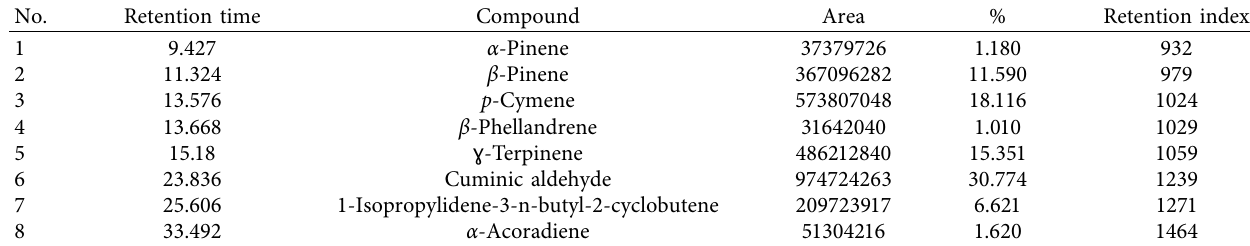
Table 1: Identifed components in C. cyminum EO using GC-MS analysis.